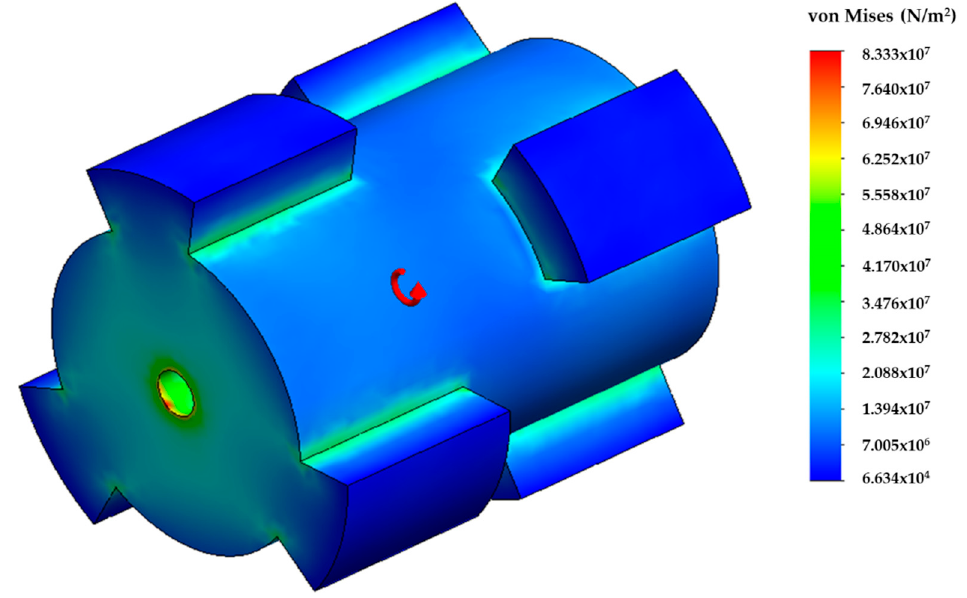
Figure 8. Mechanical stress analysis of the rotor core at 4800 rpm.